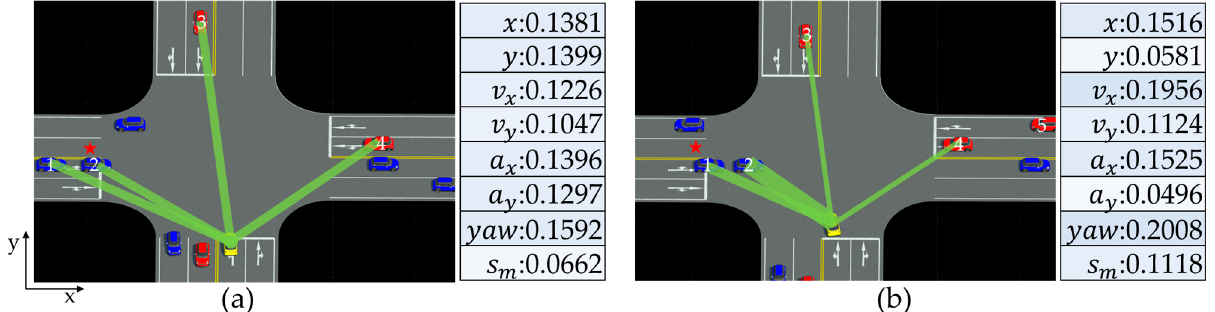
Figure 19. Changes in attention distribution during driving in the intelligent vehicle. ( a ) The intelligent vehicle has not yet entered the intersection.; ( b ) The intelligent vehicle has entered the intersection.